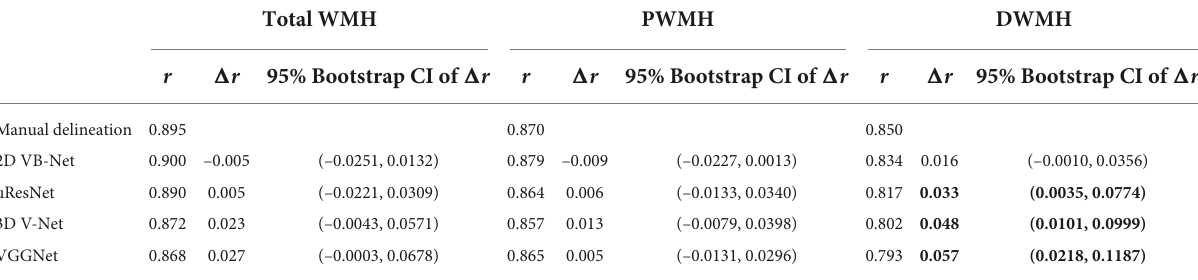
TABLE 3 Correlation analysis of WMH volumes based on Kim’s criteria extracted from manual delineation and algorithms with Fazekas scores and comparisons between correlation